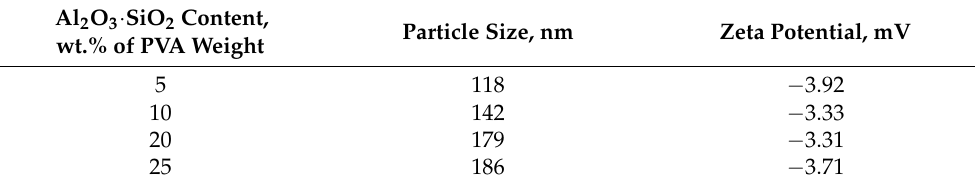
Table 1. Average size and zeta potential of Al 2 O 3 · SiO 2 nanoparticles in 1 wt.% PVA aqueous solutions. Al 2 O 3 · SiO 2